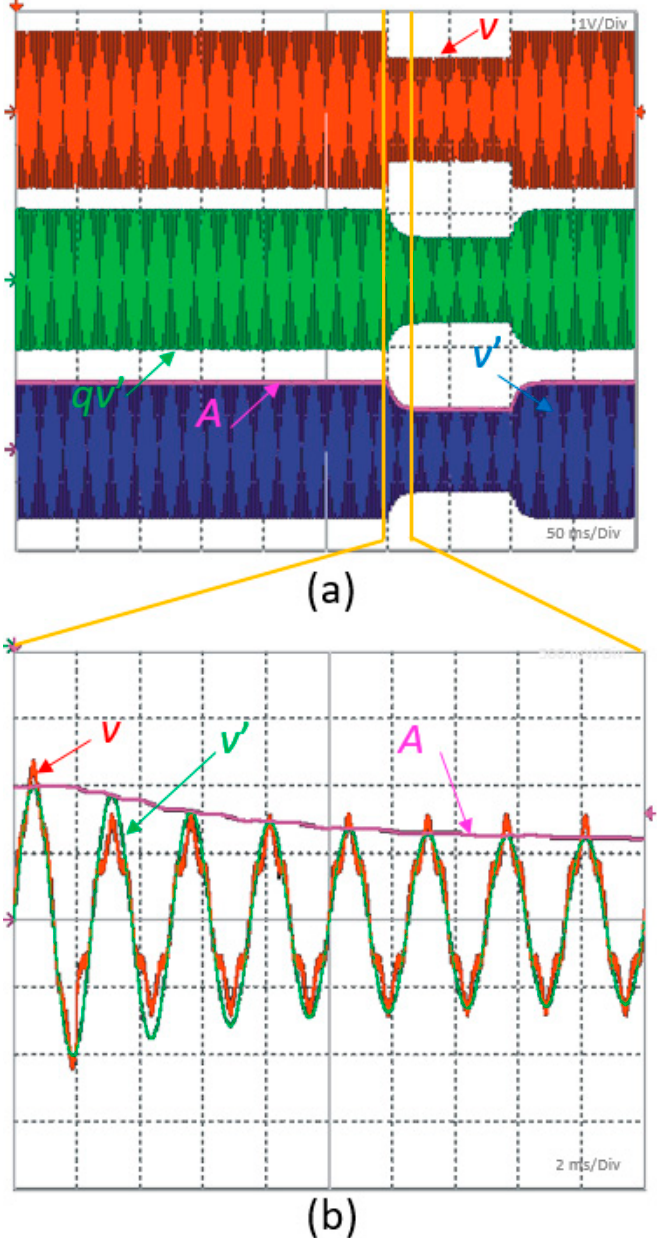
Figure 10. Grid voltage sag of 40%: ( a ) recorded waveforms of input signal ( v ), estimated sine signal ( v ’), estimated cosine signal ( qv ’), and estimated amplitude of the fundamental component ( A ); ( b ) zoomed fragment for voltage sag.